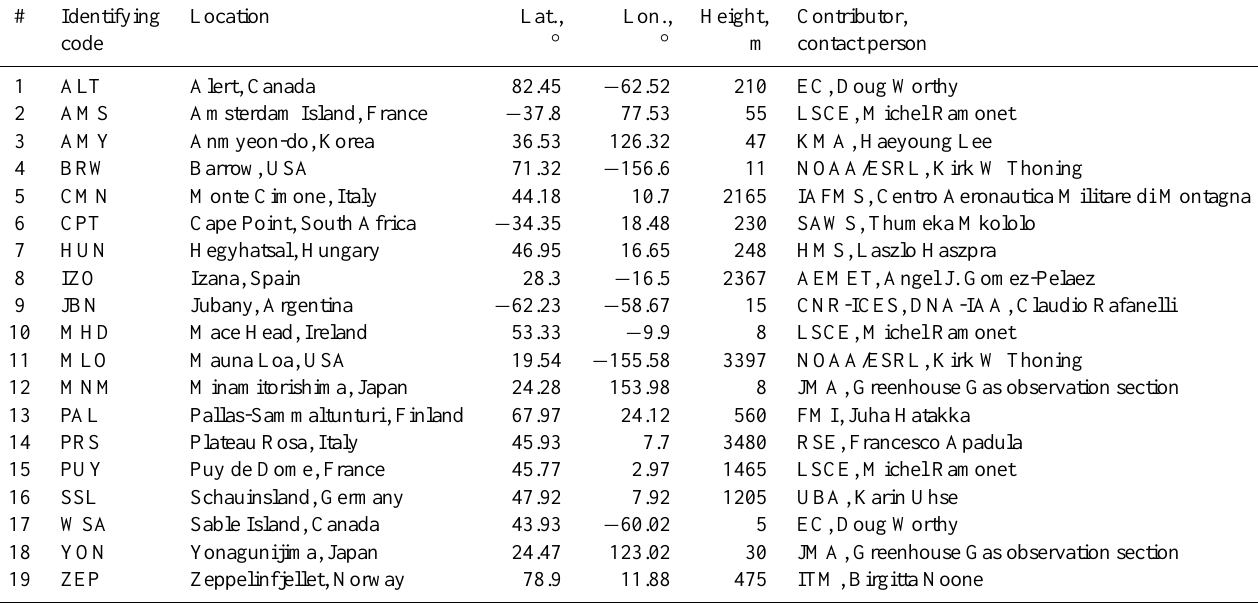
Table 2. WDCGG continuous observation sites.